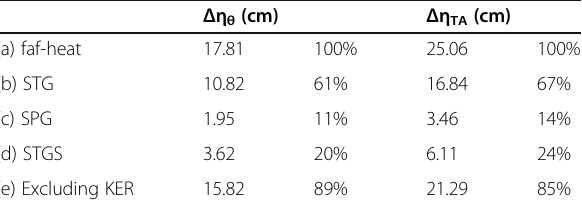
Table 1 Thermosteric sea level change ( Δ η θ ) and Δ η TA in the